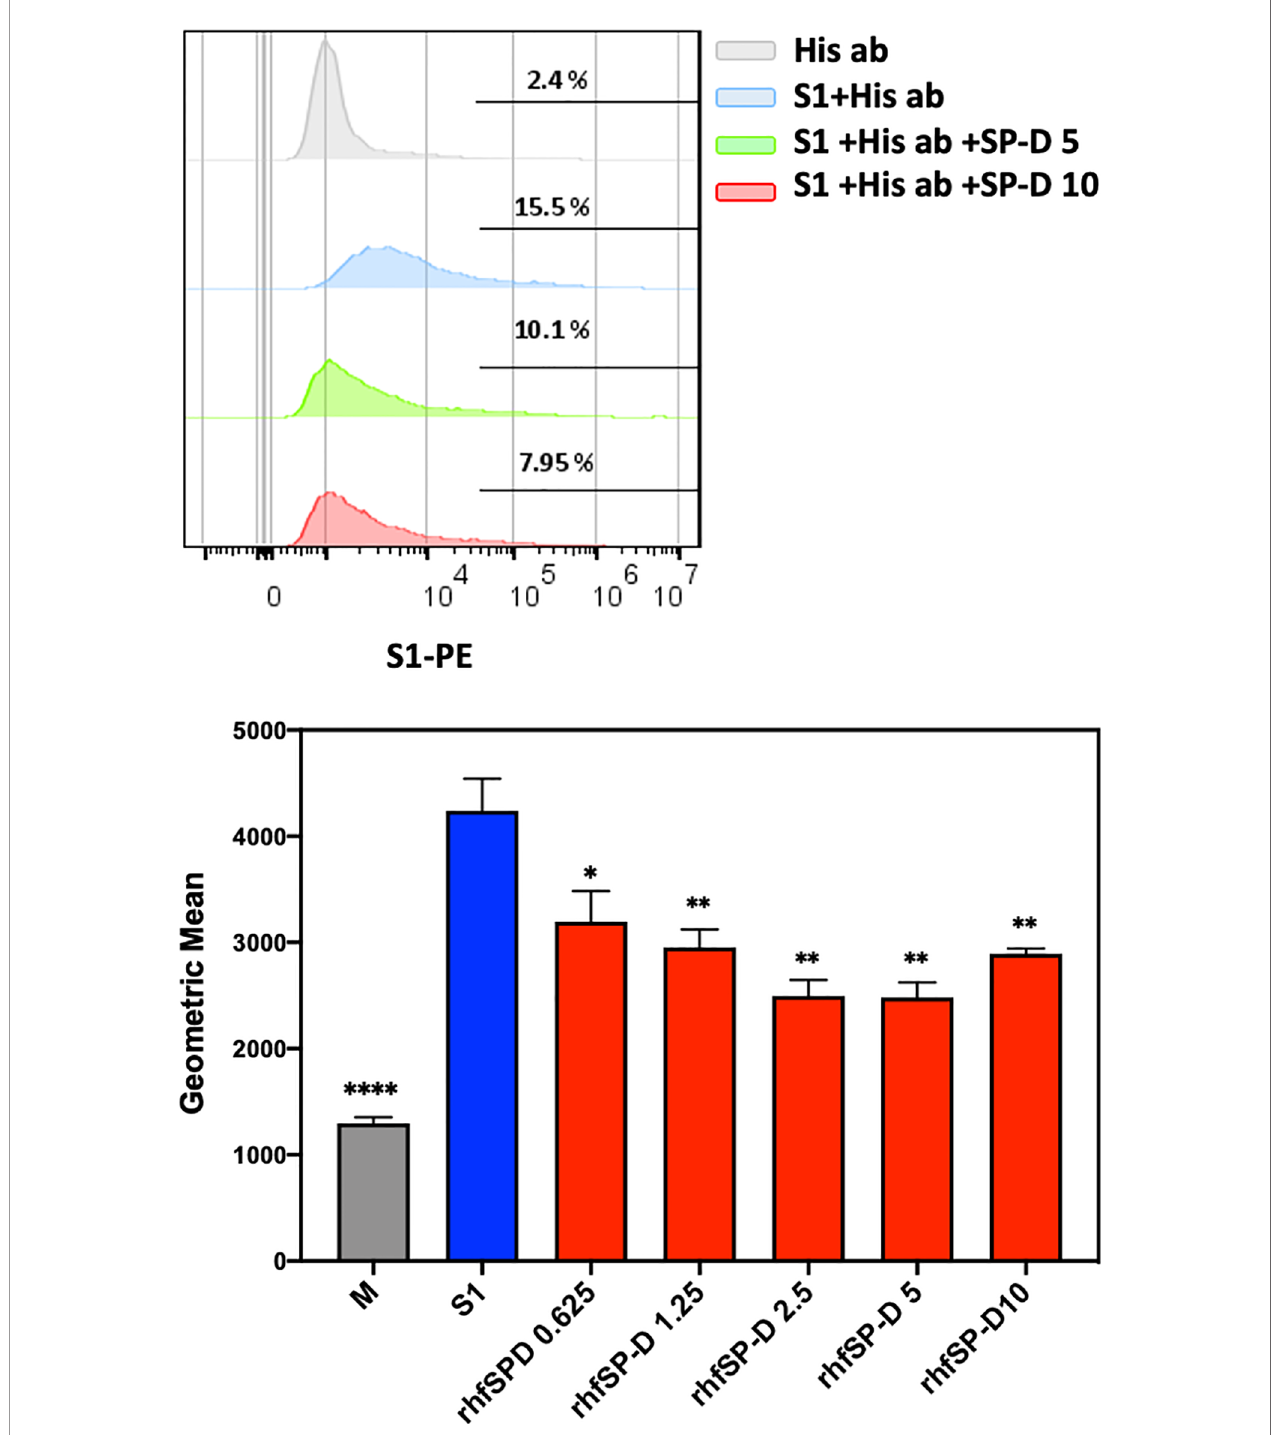
FIGURE 4 | rfhSP-D treatment inhibits the interaction between SARS-CoV-2 S1 and ACE2 receptor on HEK293T cells. Protein complex was made by tagging SARS-CoV-2 S1 protein (5 ug/ml) with anti-His antibody (10ug/ml), followed by incubation with rfhSP-D (0.625, 1.25, 2.5, 5 or 10 µg/ml) for 2h at room temperature. This complex (S1+ anti-His+rfhSP-D) was added on to HEK293T-ACE2 cells (1x10 5 cells) at 37°C for 2 h. The cells were collected and washed with FACS buffer twice and incubated with anti-mouse IgG PE conjugate (Genetex, GTX25881) (1:100) for 30 min and washed three times. The cells stained with S1 were detected by CytoFLEX. Signi fi cance was determined using the unpaired t test statistical analysis. All groups compared to S1. The error bars show SEM. M=mock (*p < 0.05; **p < 0.01; ****p < 0.0001) (n =